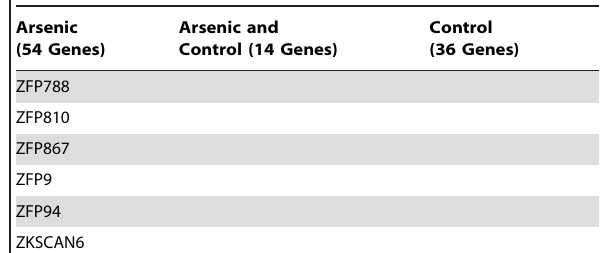
Table 1) were identified in the corresponding output Functional Annotation tables. Note, that the lists in the table do not correspond to the lists